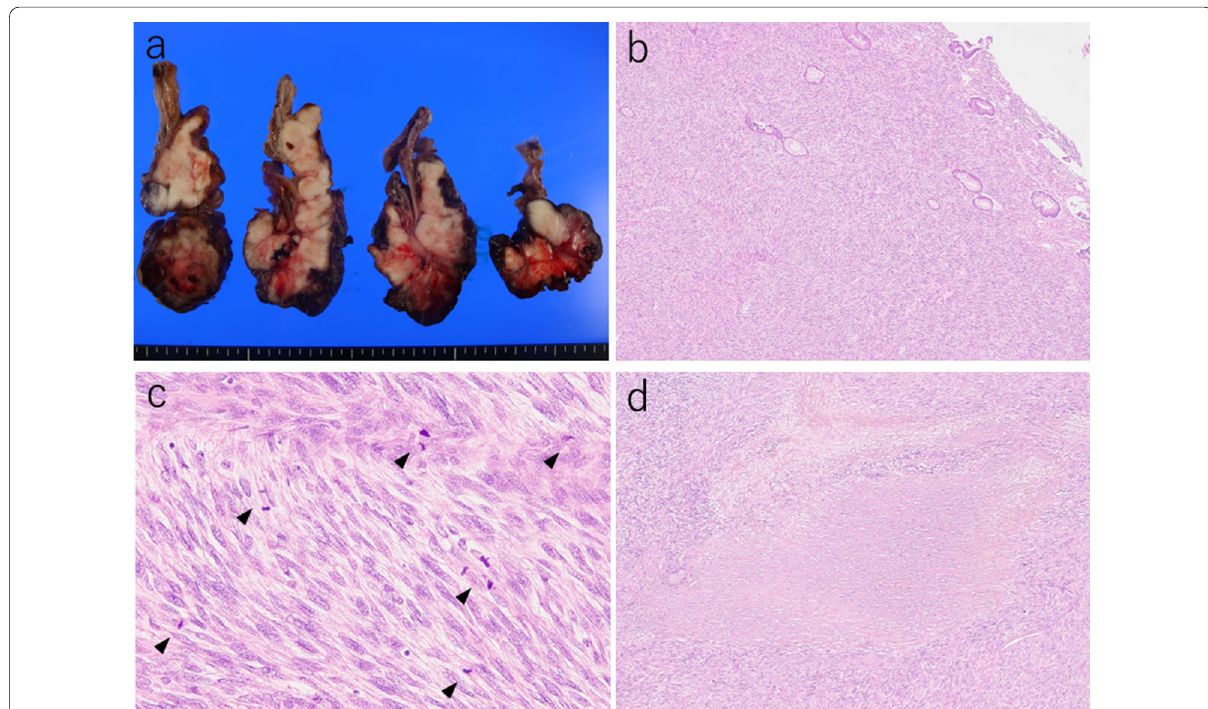
Fig. 5 Macroscopic findings of the cross-section and histological findings of the resected specimen. a Tumor was a white solid mass (10 in size) located throughout the jejunal wall. b Tumor grew by engulfing the jejunal mucosa. c Tumor cells showed a brisk mitotic activity (arrow, > 20 mitoses per 10 high power fields). d There were scattered tumor necroses